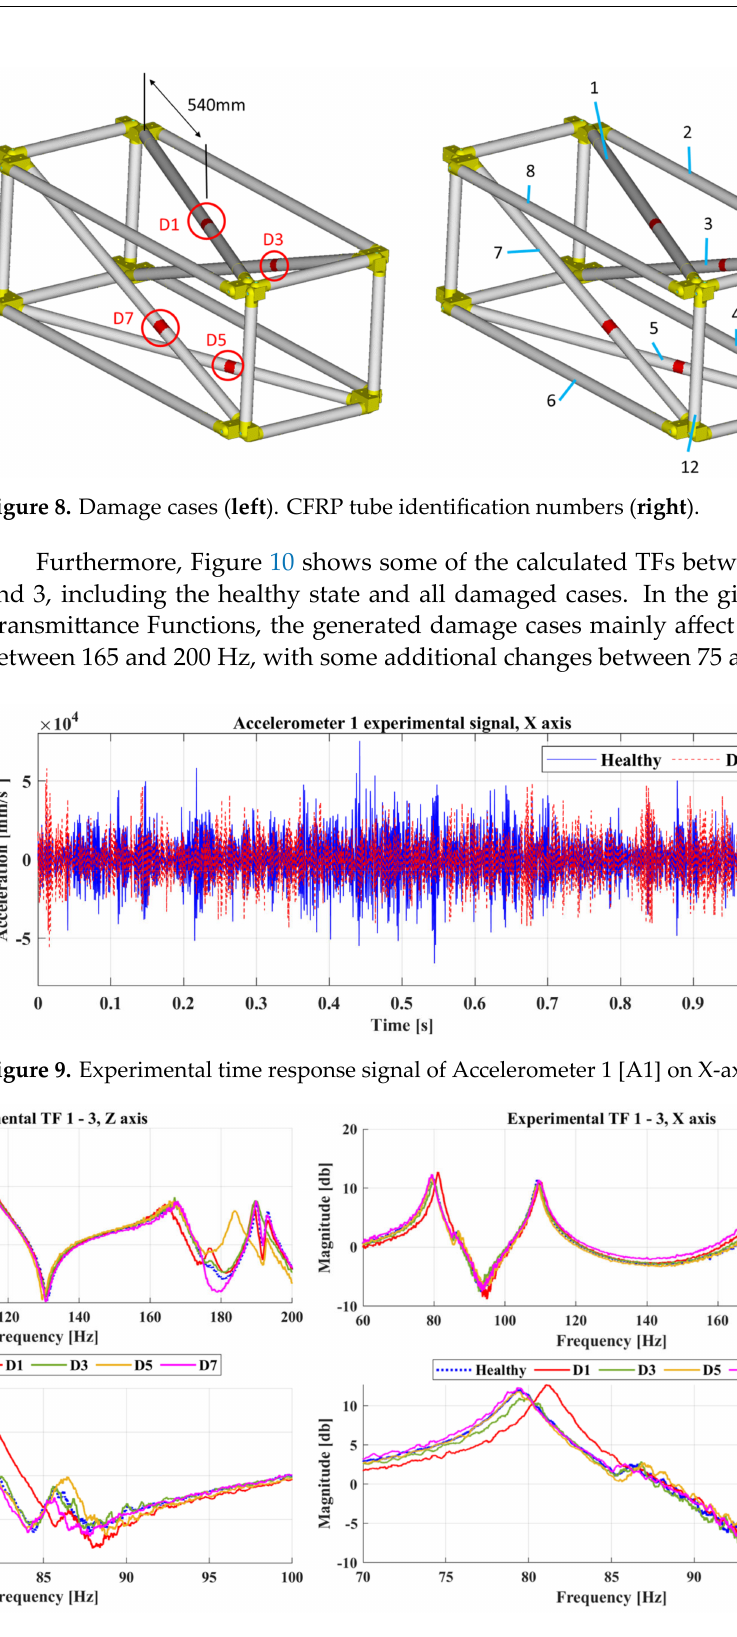
Figure 10. Experimental Transmittance Function between accelerometer 1 and 3 on the Z‑axis ( left ) and X‑axis ( right